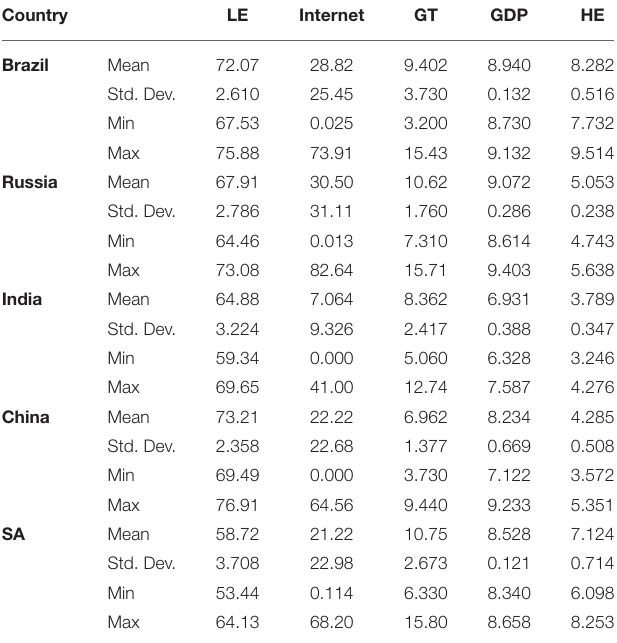
TABLE 2 | Descriptive